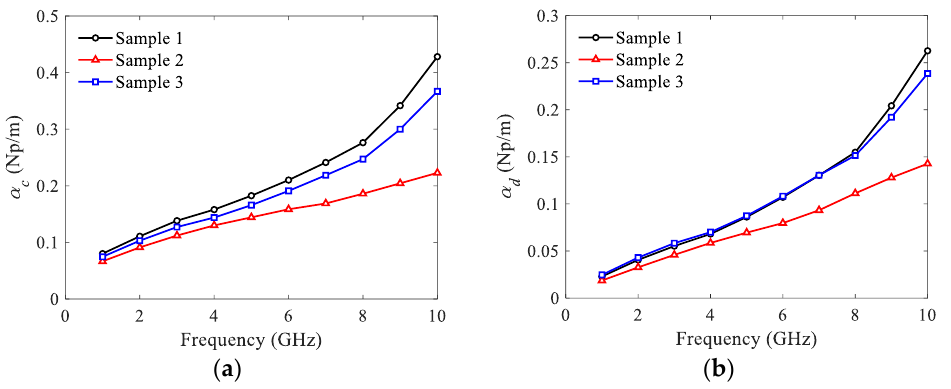
Figure 7. Attenuation constants of U-shaped corrugated SWTLs: ( a ) conductor attenuation; ( b ) dielectric attenuation.